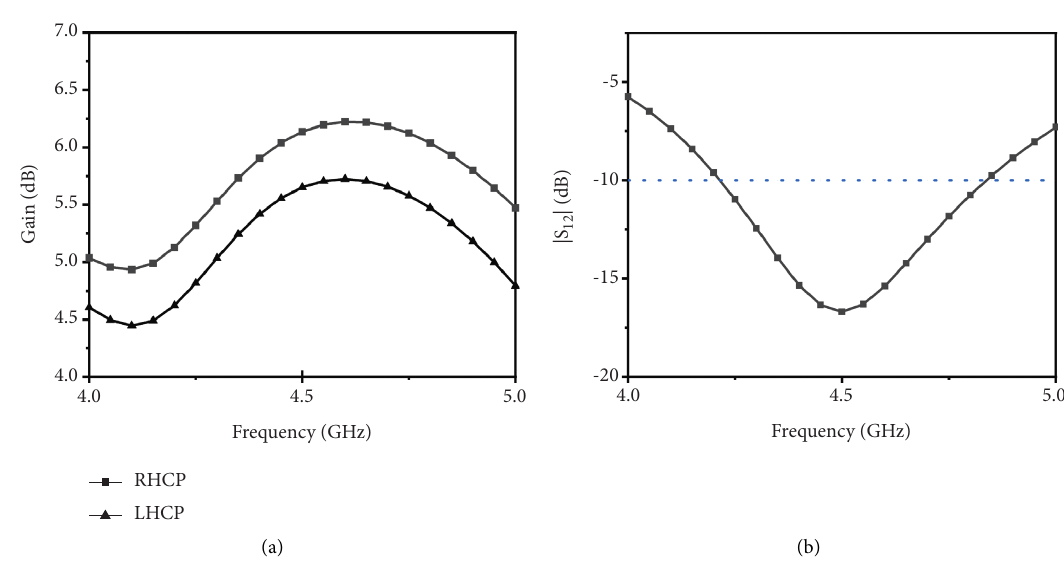
Figure 5: The simulation results. (a) Gain. (b) S